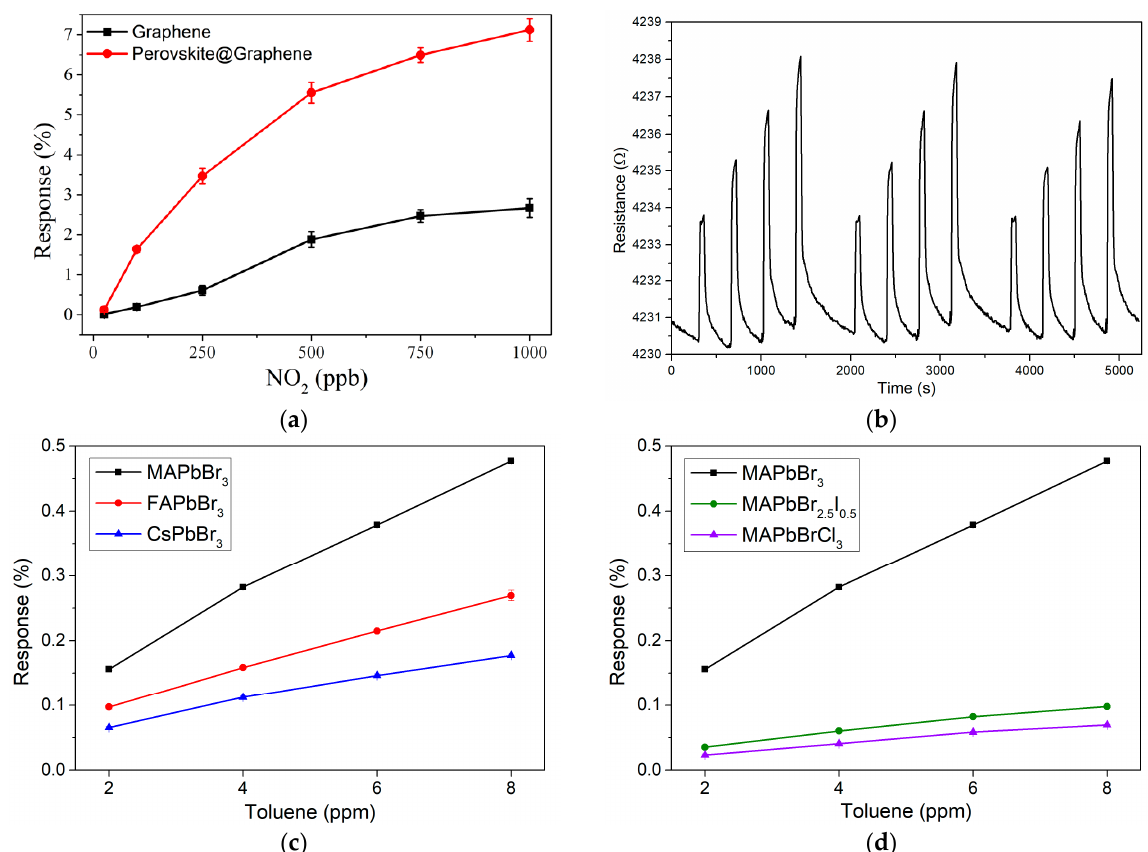
Figure 5. ( a ) Comparison of calibration curves obtained for bare and perovskite-decorated graphene detecting NO 2 . Reproduced from Sensors MDPI 2019, 19 (20), 4563 . ( b ) Example of the dynamic responses to 2, 4, 6, and 8 ppm of benzene during three cycles by using graphene decorated with MaPbBr 3 nanocrystals. Example of the calibration curves obtained for detecting toluene using lead halide perovskite with different cation ( c ) and anion ( d ) compositions. Chem. Commun., 2020, 56 , 8956–8959 . Reproduced by permission of The Royal Society of Chemistry (RSC) .